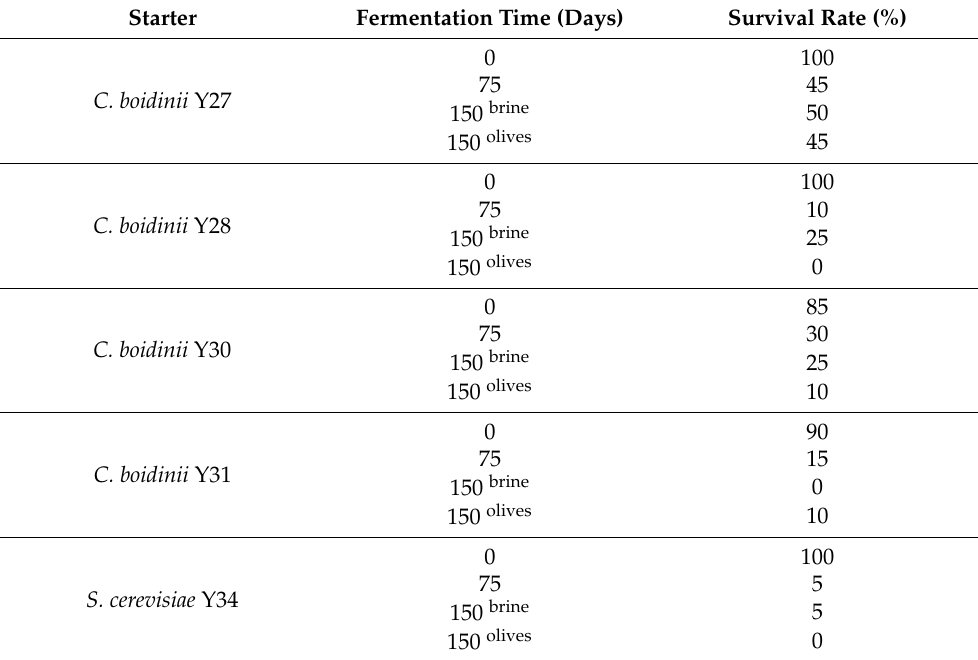
Table 1. Starter culture survival rates (%) during different time points of fermentation